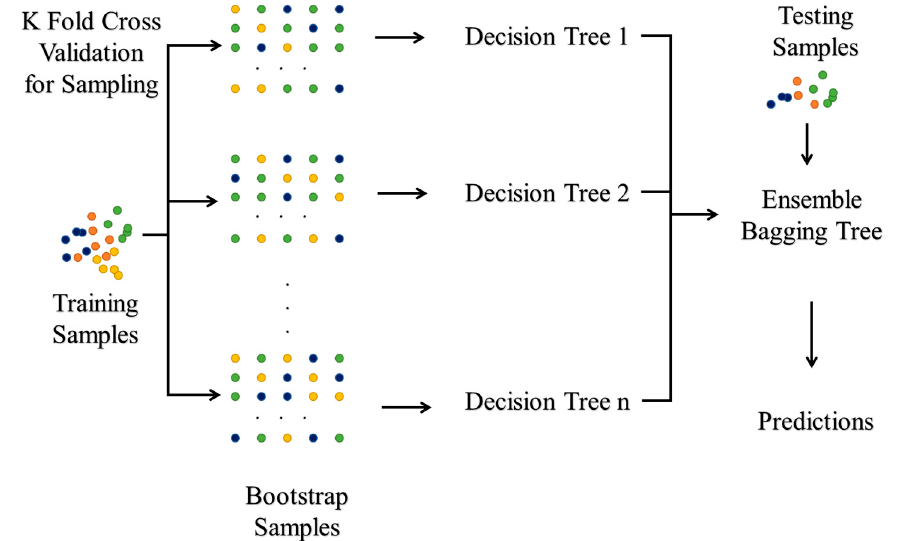
Figure 6. Ensemble Bagging Tree.